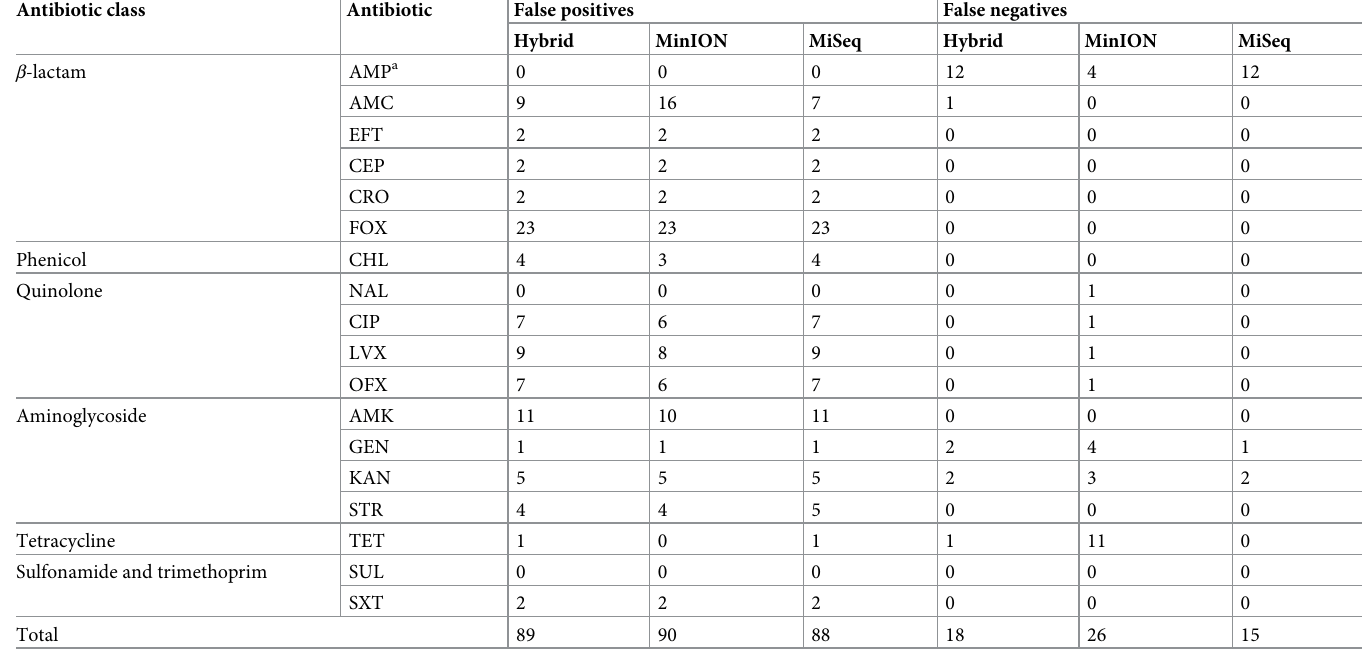
Table 5. Numbers of false positives and false negatives of antimicrobial resistance (AMR) genotypes of Salmonella isolates for each antibiotic, as predicted based on their hybrid, MinION, and MiSeq assemblies. Antibiotic